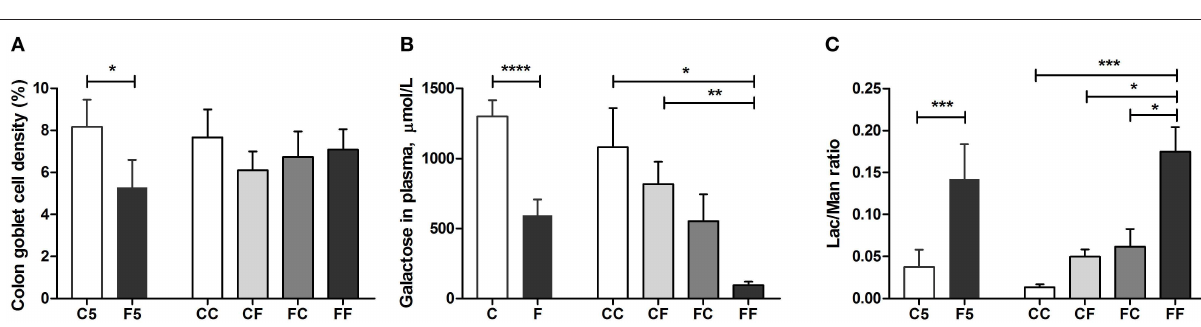
FIGURE 5 | Goblet cell density and in vivo intestinal functions. Goblet cell density in the colon (A) , intestinal hexose absorptive capacity on days 4 and 8 (B) , and intestinal permeability measure before euthanasia (C) . Values (means ± SEM) designated with asterisks are significantly different, * P < 0.05, ** P < 0.01, *** P < 0.001, **** P < 0.0001. n = 8–11 for C5 and F5 groups, n = 33 each for C and F groups, and n = 7–14 for CC, CF, FC, and FF groups. C, colostrum feeding for the first 4 days; C5, colostrum feeding until day 5; CC, colostrum feeding until day 9; CF, 4 days colostrum feeding followed by formula feeding until day 9; F, formula feeding